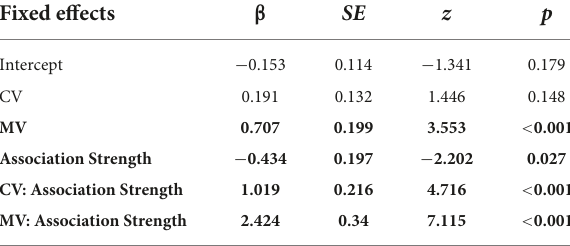
TABLE 8 Model for association strength exploration in the DS